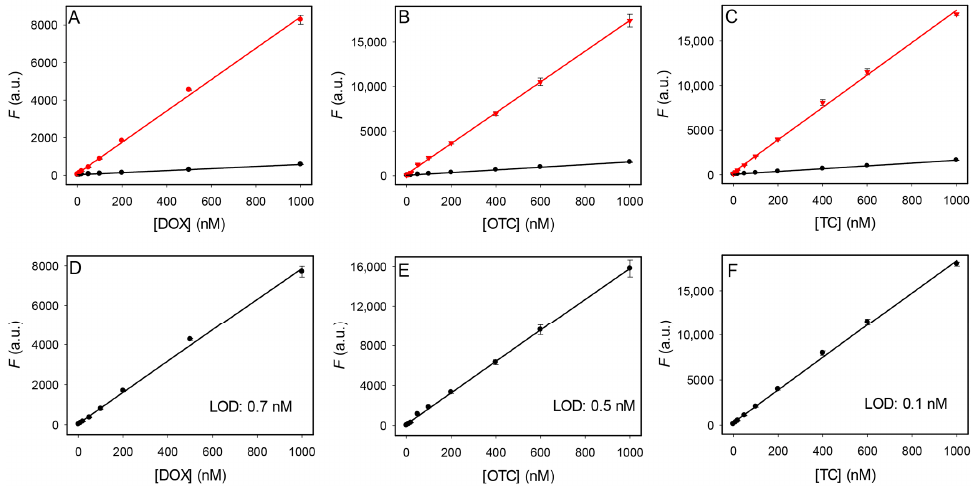
Figure 7. Fluorescence intensity of ( A ) DOX, ( B ) OTC, and ( C ) TC in the absence (black dots) and presence (red dots) of 2 μ M OTC5 aptamer. Fluorescence difference of ( D ) DOX, ( E ) OTC, and ( F ) TC in the presence and absence of 2 μ M OTC5 aptamer. The measurements were performed in pH 6 buffer with 2 mM Mg 2+ .